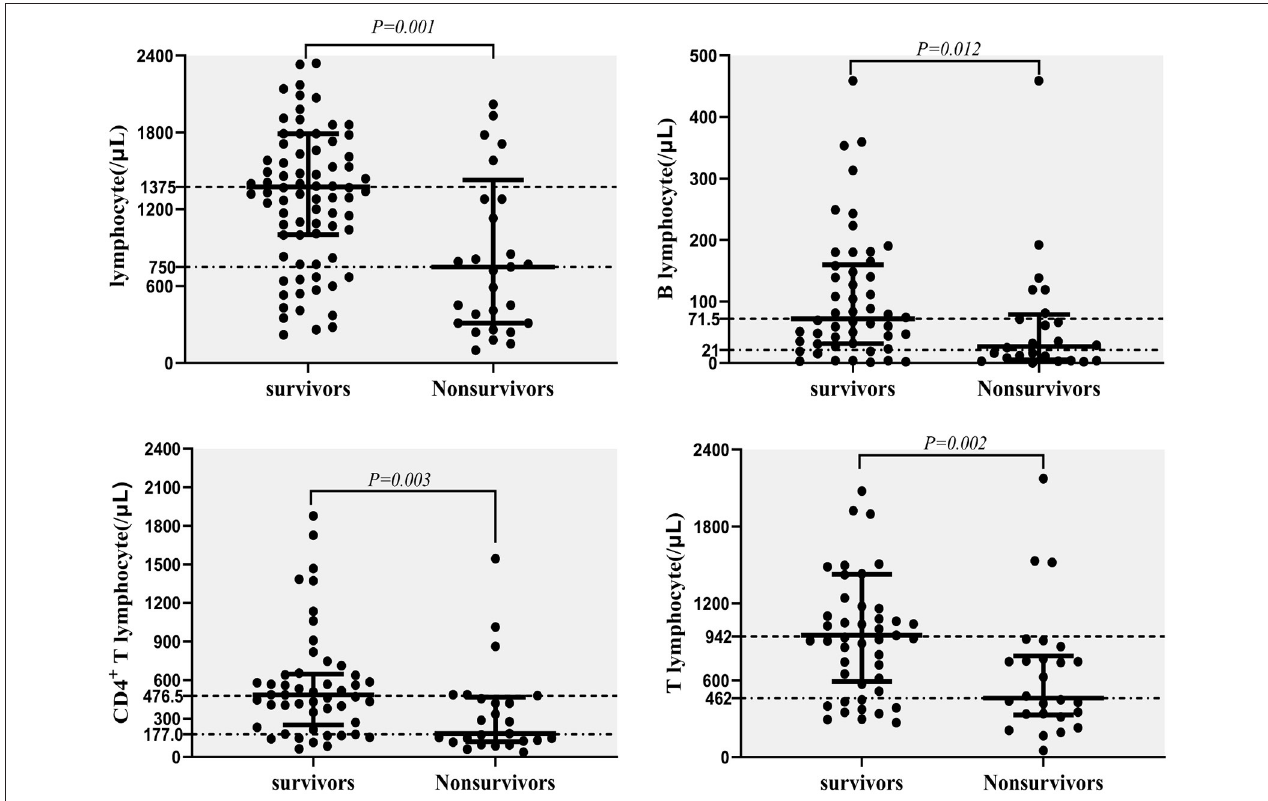
FIGURE 5 | Predictors for mortality in NTM disease; lymphocyte counts (/ µ L), T lymphocyte counts (/ µ L), CD4 + T lymphocyte counts (/ µ L), and B lymphocyte counts (/ µ L) in survivors and non-survivors.